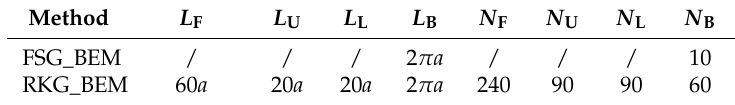
Table 2. Mesh specifications for the case shown in Figure 5. Refer to Table 1 for the notes of the symbols.